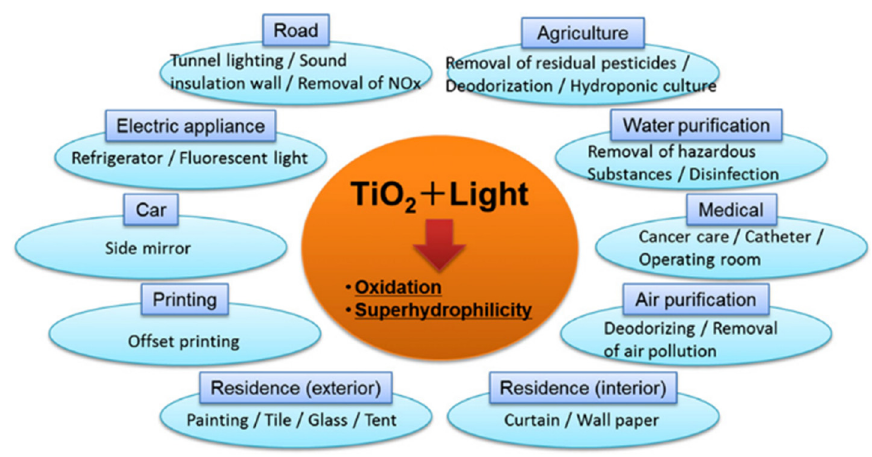
Figure 12. Application of TiO 2 Photocatalyst [42]. Reproduced with permission from Nakata et al. Copyright © 2022 Elsevier.